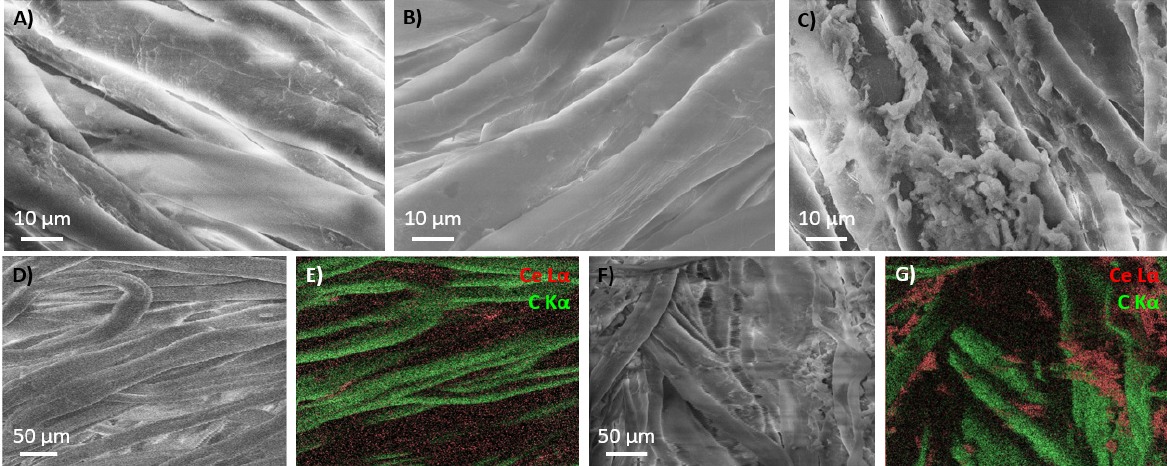
Figure 4. SEM images of the textile after ultrasonic treatment in the cellulose dispersion ( A ), the nonmodified CeO 2 sol ( B ) and the CeO 2 /cellulose sol ( C ). SEM images and the corresponding cerium- and carbon-distribution EDS maps of the textile after ultrasonic treatment in nonmodified CeO 2 sol ( D , E ) and CeO 2 /cellulose sol ( F , G ).